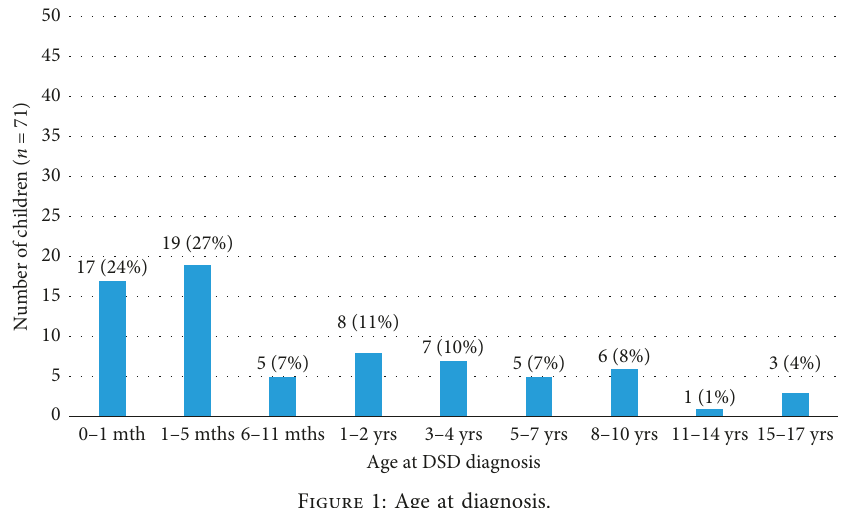
Figure 1: Age at